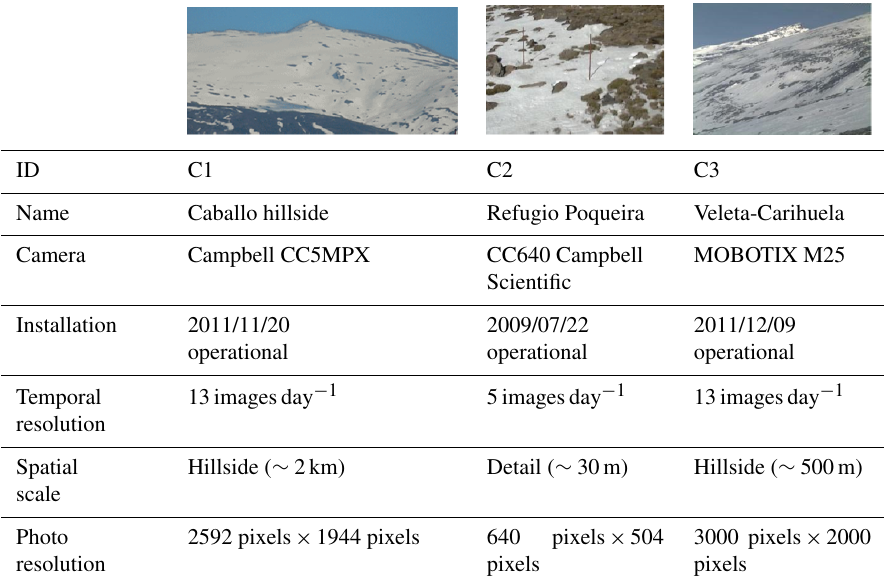
Table 2. Main characteristics of the time-lapse cameras in the Guadalfeo Network: elevation (ma.s.l.), date of installation, instruments, frequency and spatial resolution. In situ pictures of both their locations and scenes are also shown. Dates are provided as